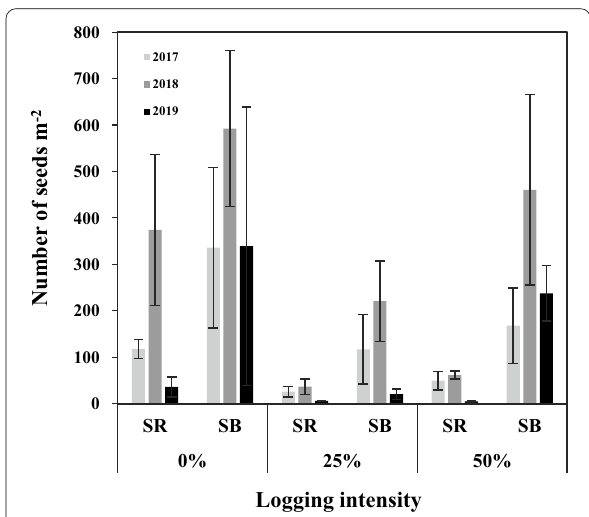
Fig. 3 Densities of seed rain (SR) and soil seed bank (SB) for all woody species for the control (0%), 25% (25% of the basal area removal), and 50% (50% of the basal area removal) logging intensities in October 2017, 2018, and 2019. The values are the presented as means